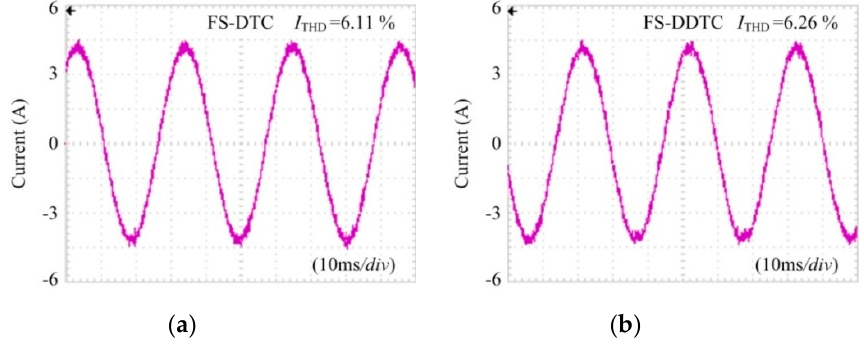
Figure 8. The waveforms of stator current when using: ( a ) FS-DTC; ( b ) FS-DDTC.